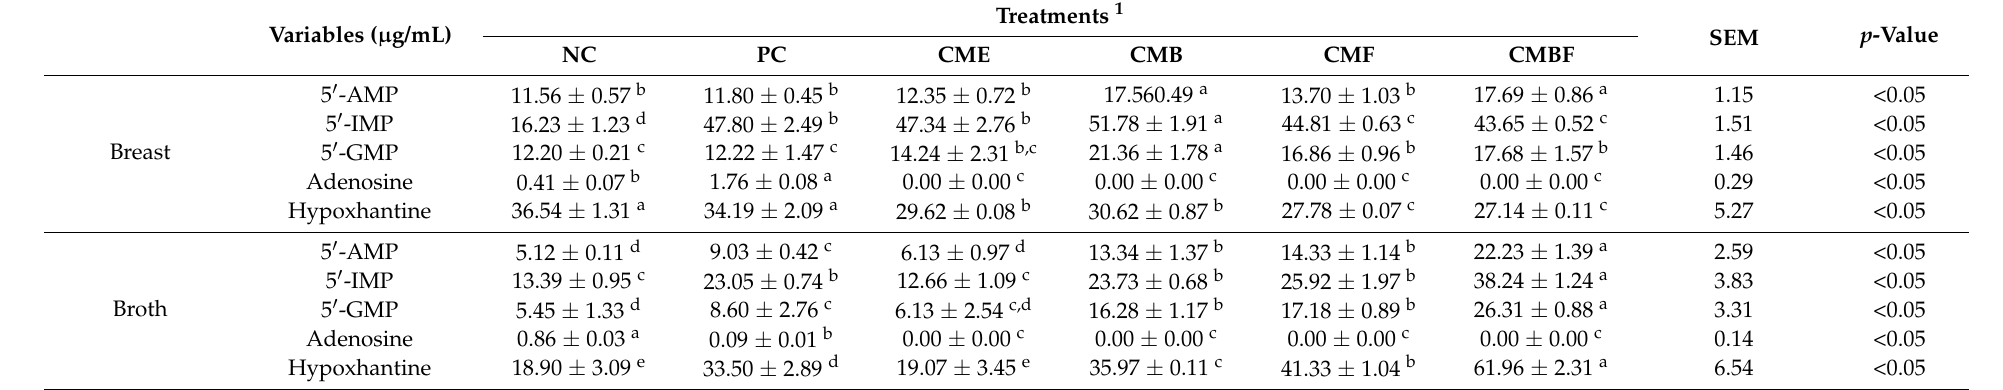
Table 5. Taste-related nucleotides of the Korean ginseng chicken soup that was hydrolyzed with Cordyceps militaris mushroom